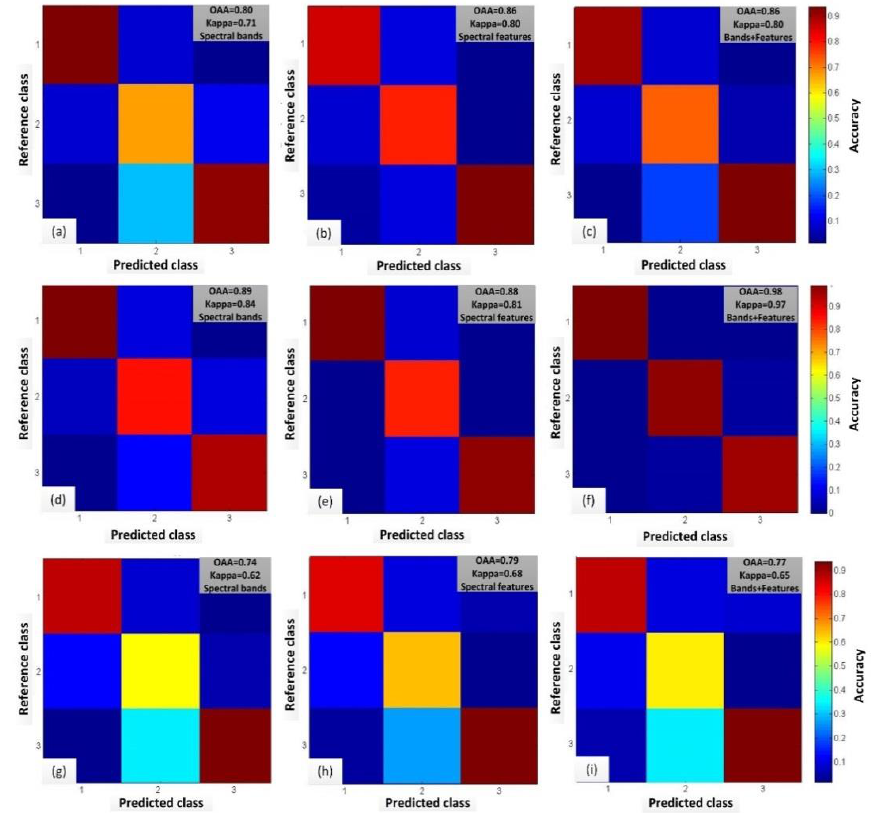
Figure 6. Visualization of tea plant growth vigor monitoring results using a confusion matrix heat map. ( a–c are results using RF, d–f are results using GA-SVM, and g–i are results using KNN).